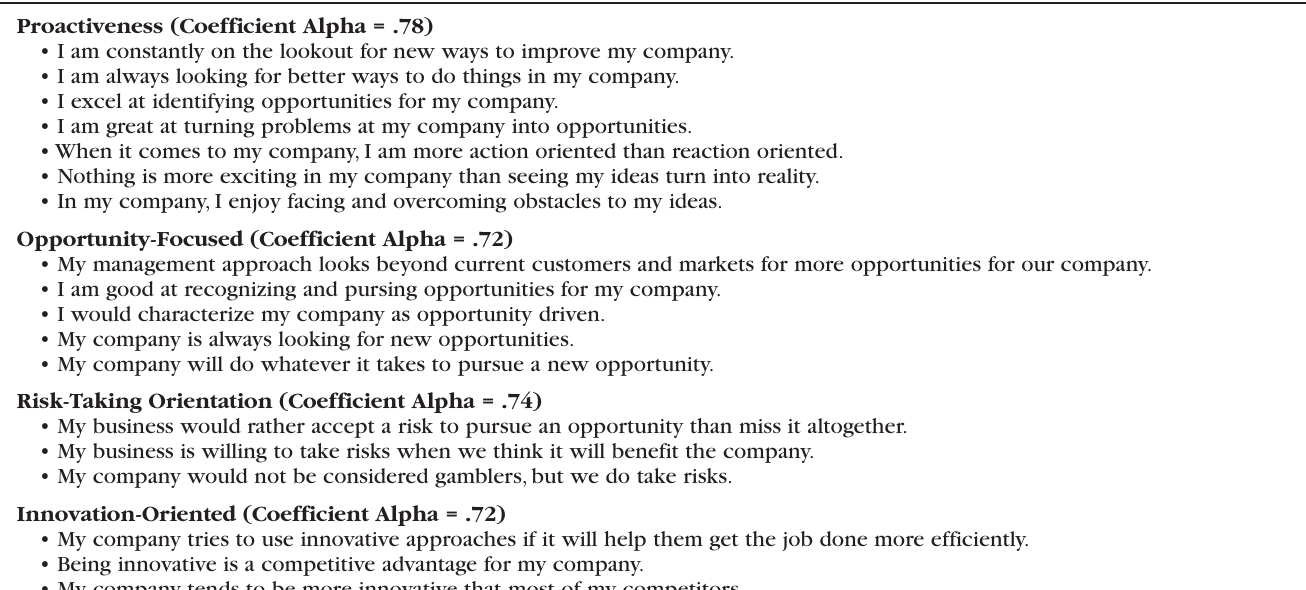
Table 4. Entrepreneurial Marketing Dimension